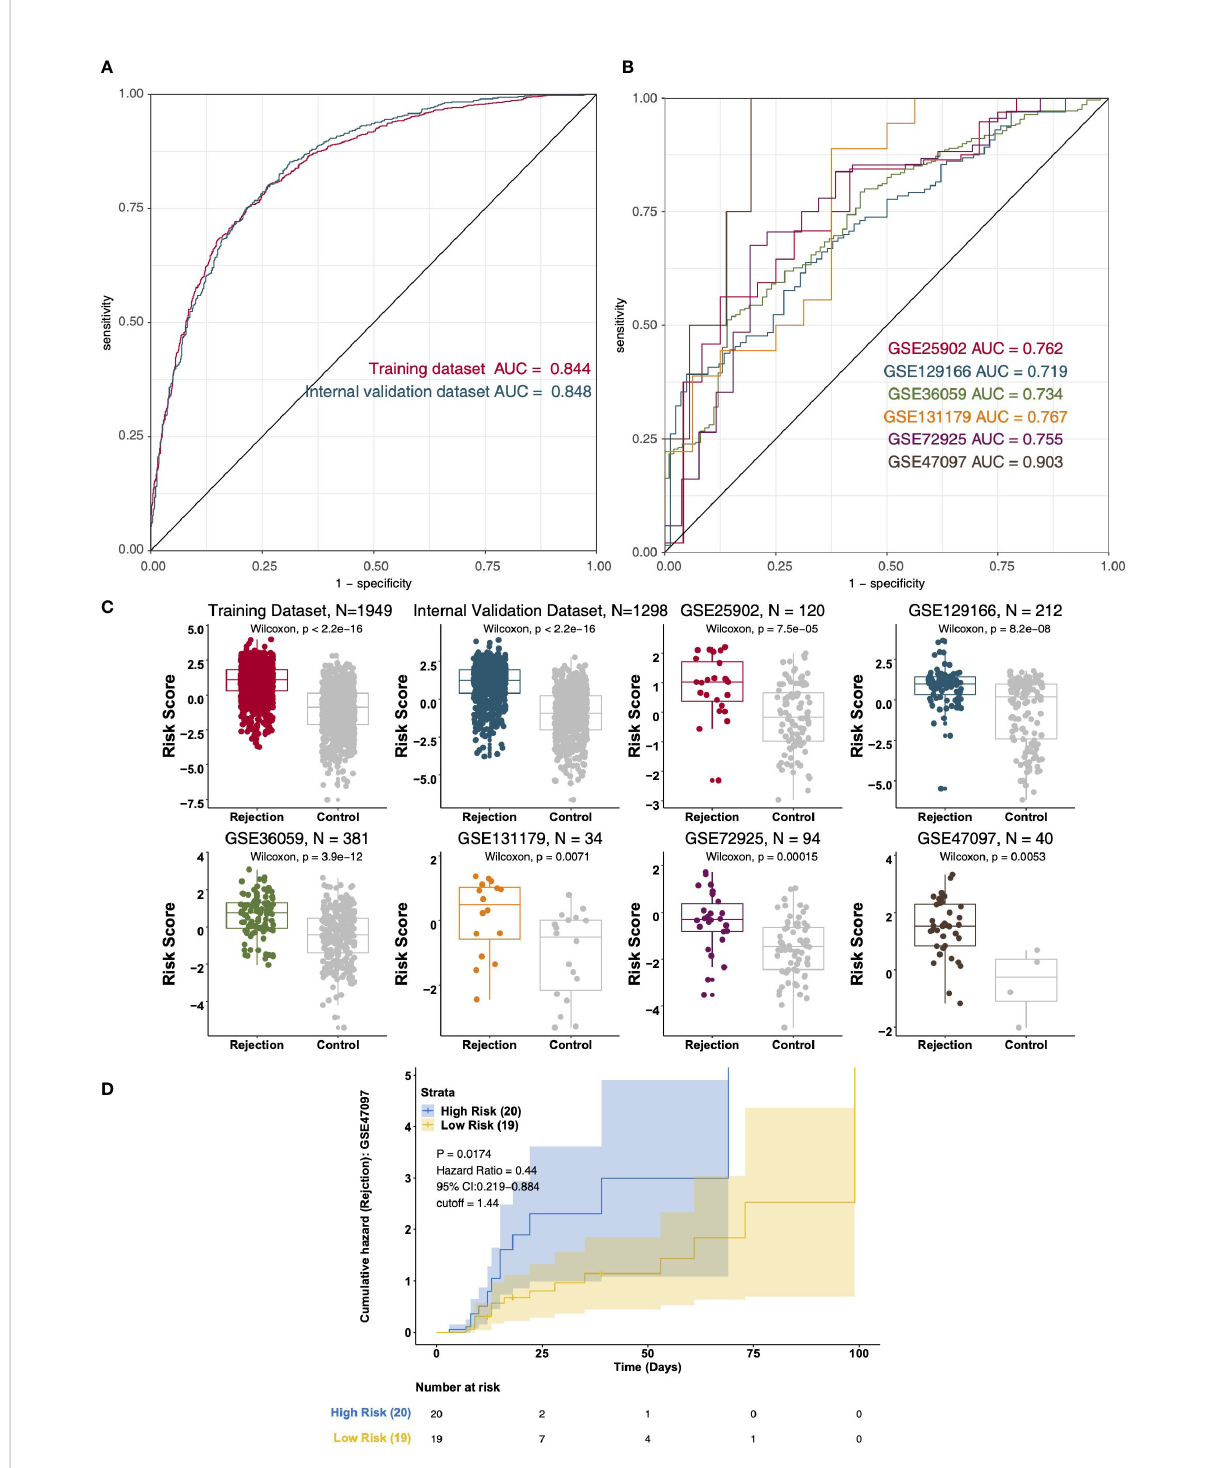
FIGURE 7 The result of the data integration Analysis. (A) ROC analysis of risk scores based on the training data dataset and internal validation dataset. (B) ROC analysis of risk scores based on the external validation dataset (GSE25902, GSE129166, GSE36059, GSE131179, GSE72925, and GSE47097). (C) Boxplot showing the difference in the risk scores between rejection and control groups in the training dataset, internal validation dataset, and external validation dataset (GSE25902, GSE129166, GSE36059, GSE131179, GSE72925, and GSE47097). Survival characteristics of the patients in the GSE47097 based on the risk scores (D)